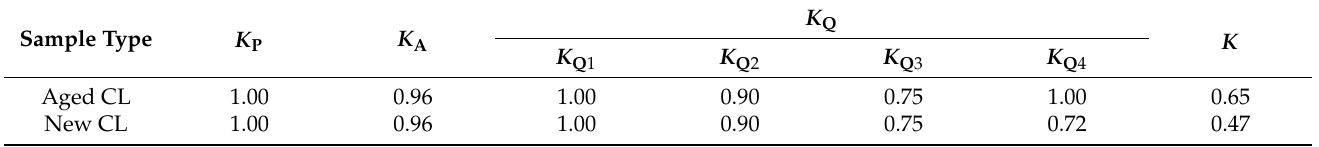
Table 6. Coefficients for calculating the parallel-to-grain compressive strength